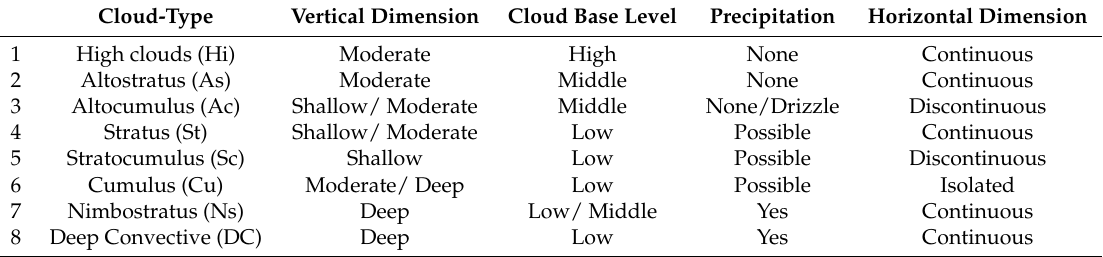
Table 1. Characteristics of cloud